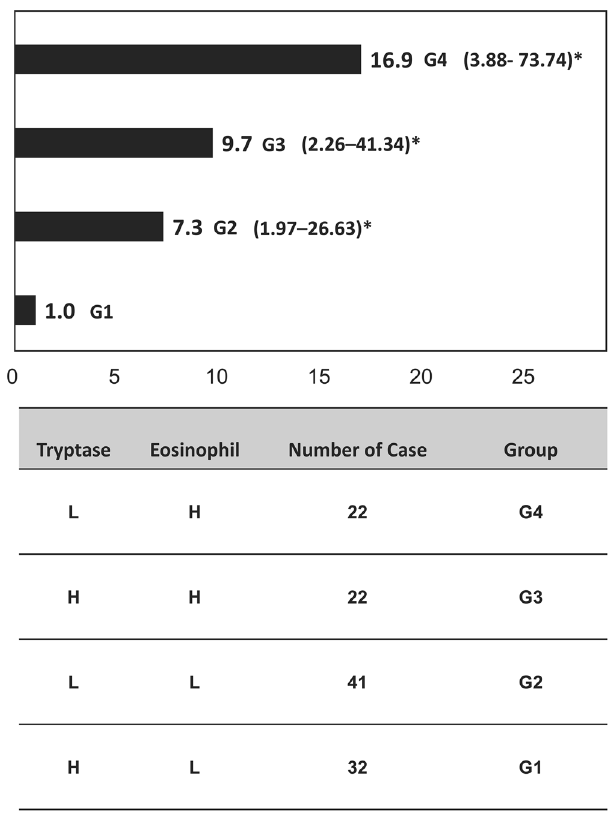
Figure 2. Adjusted odds ratio (AOR) for developing asthma exacerbation during the 1-year follow-up period based on blood tryptase and eosinophil levels. High (H) and low (L) levels of serum tryptase and blood eosinophil count were defined on the basis of the cut-off values of 1448 pg/mL and 291 cells/µL, respectively. * denotes p value < 0.05. When G1 group is defined as reference, the AOR with 95% confidence intervals (95% CI) and p value for asthma exacerbation during the 1-year follow-up period for G4, G3, and G2 are 16.92 (3.88– 73.74, p < 0.001), 9.67 (2.26–41.34, p = 0.002), and 7.25 (1.97–26.63, p = 0.003),